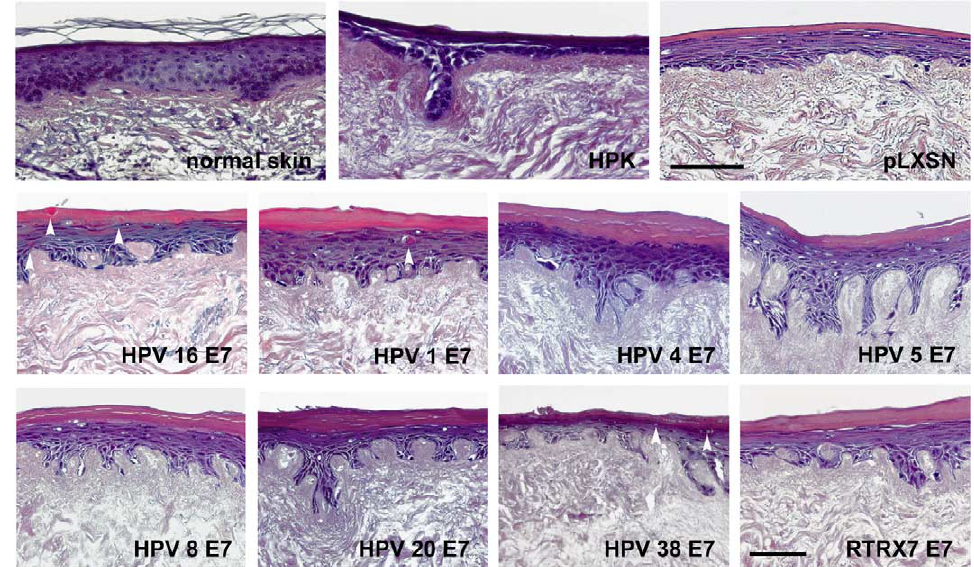
Fig. 2. Altered histology in organotypic skin cultures infected with E7 of cutaneous HPV types. Epidermal human primary keratinocytes (HPK) were non-infected, infected with the control vector pLXSN, or pLXSN-HPV × E7 containing recombinant retroviruses and used in organotypic skin cultures. For histological examination tissue sections were stained with hematoxylin and eosin. Retrovirus infected cultures both with and without HPV E7 sequences showed a distinct hyperkeratosis, which was absent in normal human skin and non-infected HPK. An enhanced hyperkeratosis was observed in E7 infected cultures of any HPV type and the strongest hyperkeratosis was present with HPV 4, which is characteristic for cutaneous warts. Cultures infected with pLXSN showed a normal morphology of the suprabasal layers. The histology of E7 infected skin cultures varied to different degrees depending on the HPV type. The epithelium of HPV 16 and HPV 1 infected HPK were disorganised and showed dysplastic morphology (marked with white arrows). Parakeratosis, which is characteristic of HPV induced warts, was only observed in HPV 38 infected tissues. HPV 5 showed distinct papilla-like structures and the largest nuclei were present in the granular layer and not in the spinous layer. HPV types used to infect HPK are denoted. Original magnification was × 200. Scale bar: 100